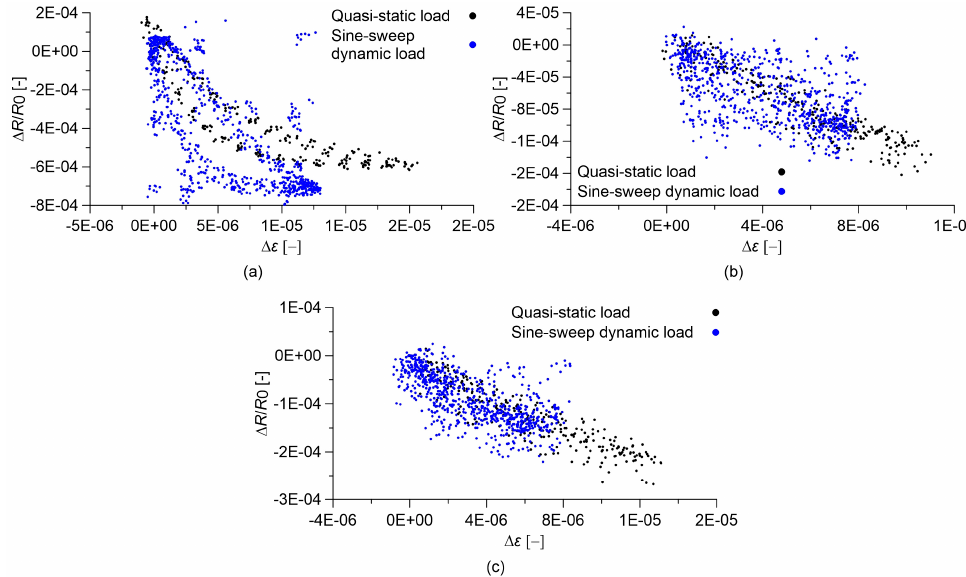
Figure 11. Relative change in electrical resistance versus applied strain of nanocomposite concrete specimens. In the plots, R 0 is the electrical resistance value with a preload of 0.5 kN. Comparison between results obtained under sine-sweep dynamic compression loads and those obtained under quasi-static compression loads: concrete with ( a ) 0.00% MWCNTs; ( b ) 0.50% MWCNTs; ( c ) 1.00% MWCNTs.